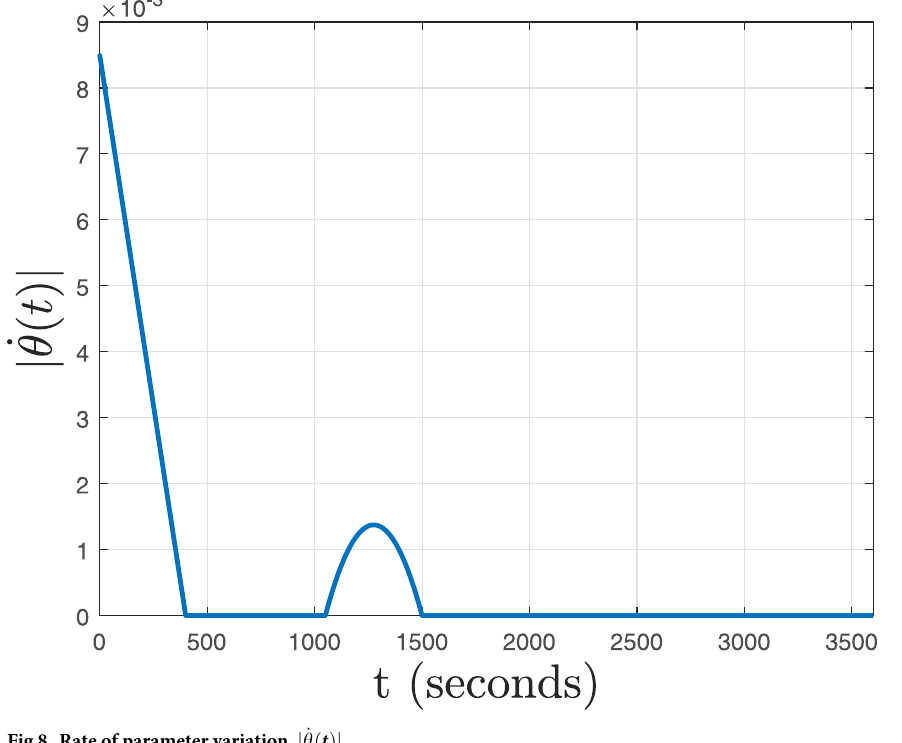
PLOS ONE | https://doi.org/10.1371/journal.pone.0256408 August 20,